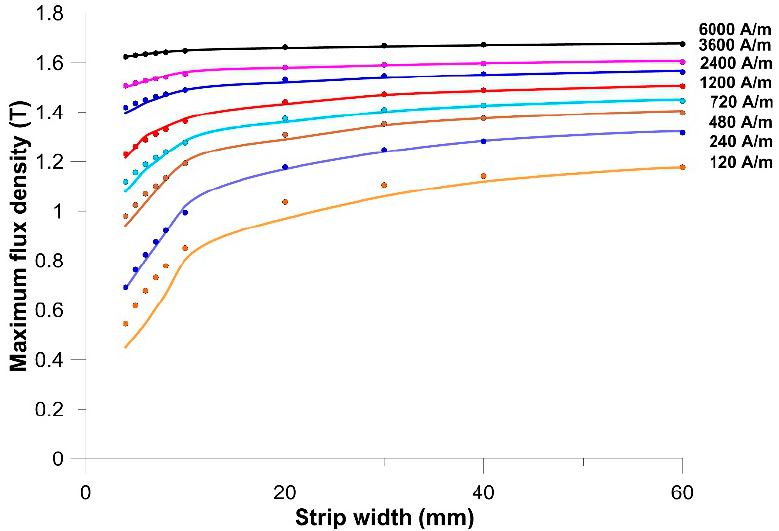
Figure 7. Comparison of the average flux density amplitude. The measurement (lines) and simulation (points) results. The strips cut at an angle of 0 degrees. Magnetic field strength changed in the range from 120 A/m to 6000 A/m.